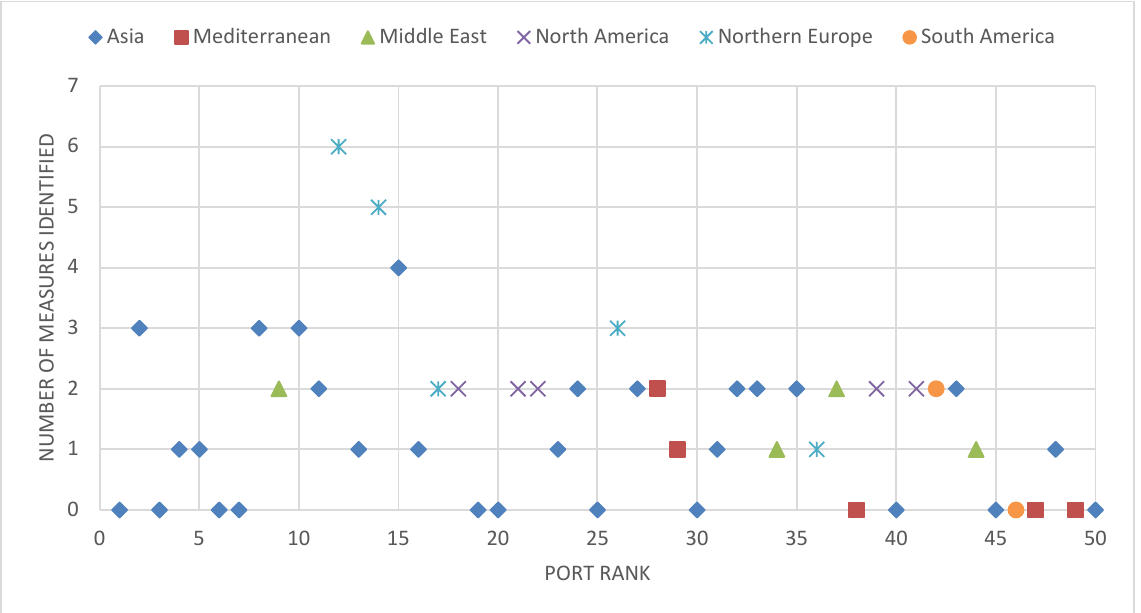
Figure 2. Number of reefer-related measures by port ranking and region (source: own compilation, based on Lloyd’s List (Lloyd’s List,